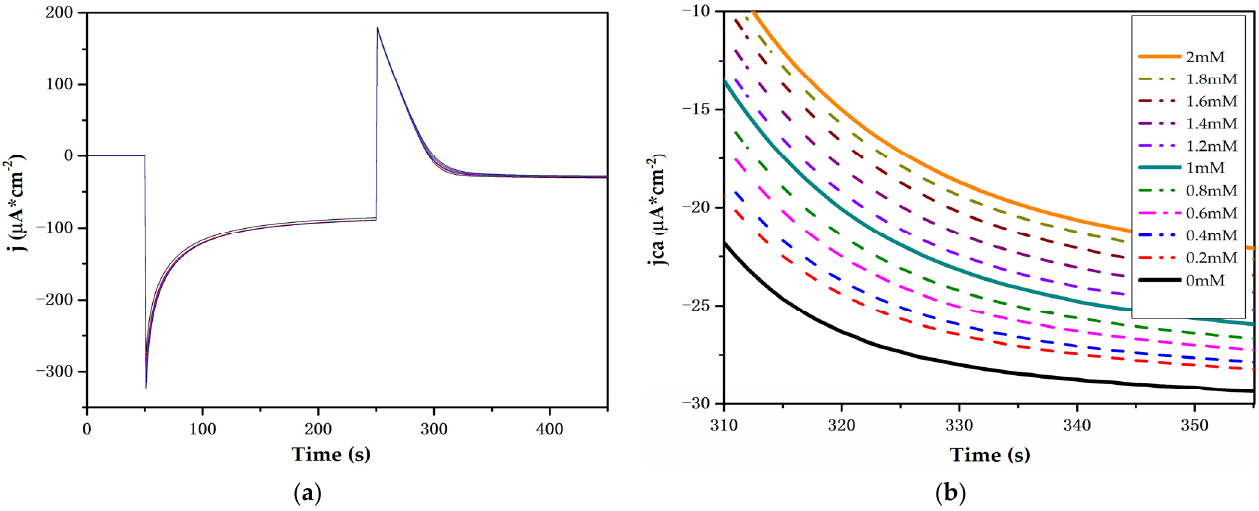
Figure 8. ( a ) Ti/TiO 2 electrode response to double-pulse chronoamperometry in a pH 7 PBS and glucose from 0 to 2 mM. ( b ) Magnification of the second chronoamperometric pulse region.